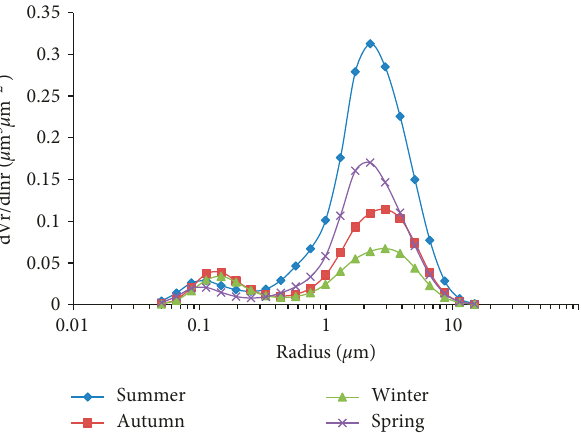
Figure 6: Seasonal averaged volume size distribution over Karachi during the study